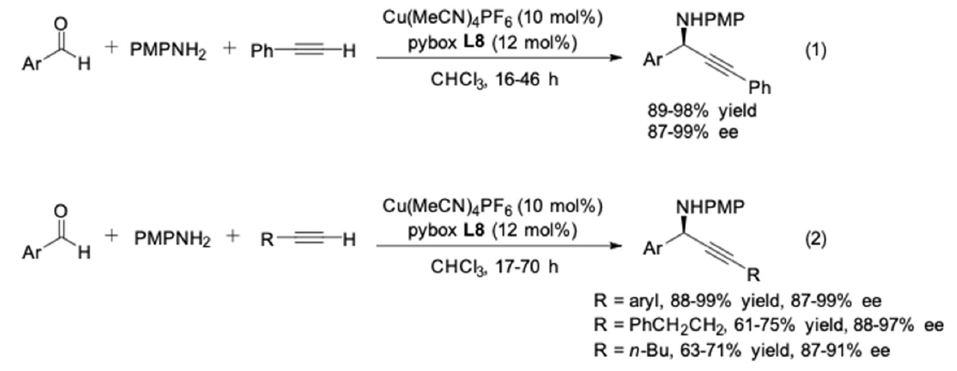
Figure 5. Cu(I)/ s -Bu-pybox-diPh-catalyzed AA 3 -couplings.